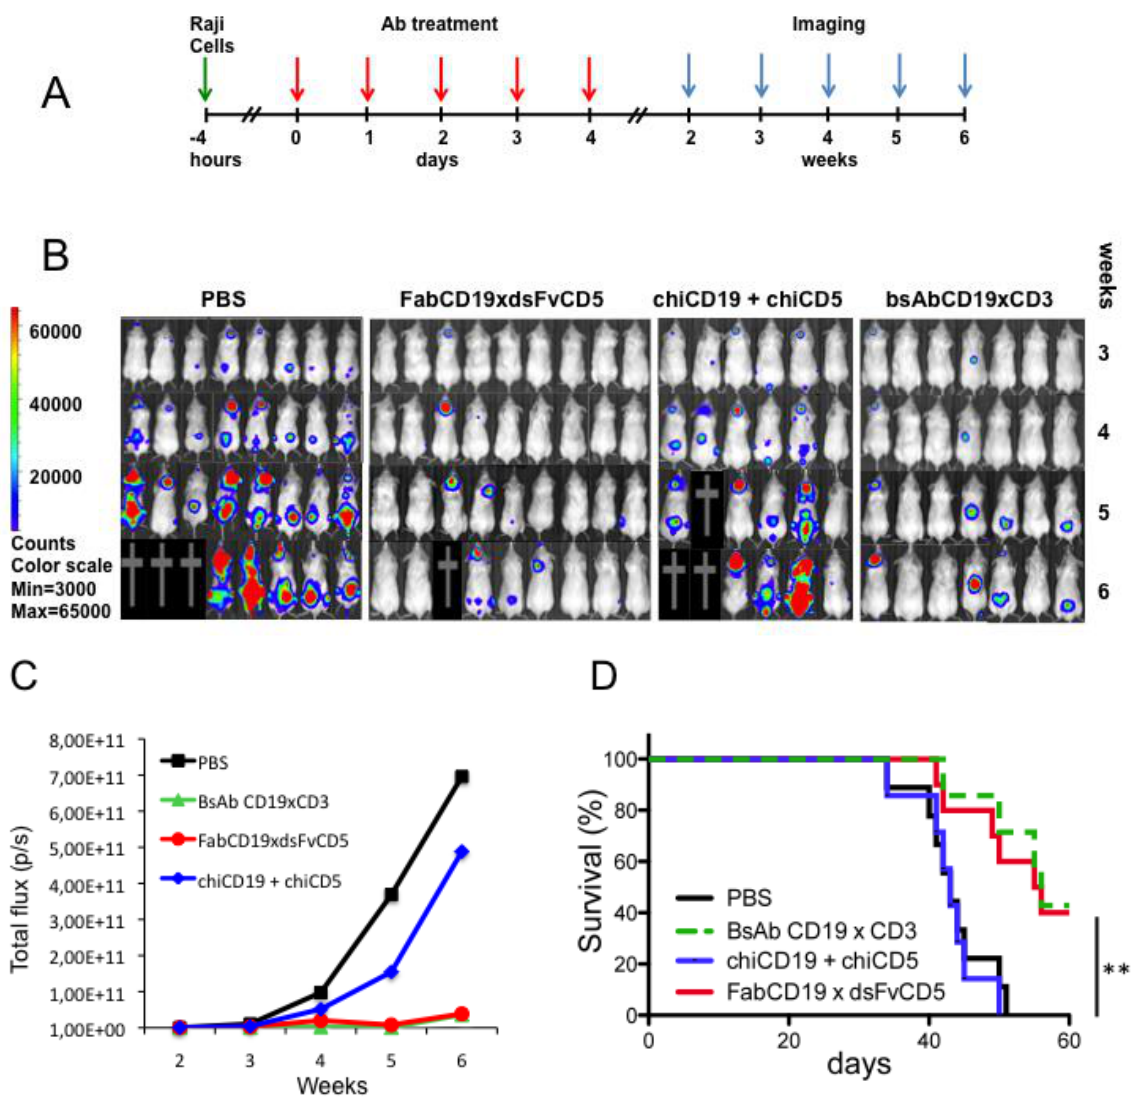
Figure 5. Influence of bsAb treatment on lymphoma growth in vivo . ( A ) Experimental design: NOD/SCID mice were intravenously inoculated with luciferase-transduced Raji lymphoma cells in combination with preactivated PBMC. Mice received five intraperitoneal antibody injections at the subsequent five days. Tumor growth was monitored by bioluminescent imaging for 6 weeks. ( B ) Luciferase imaging of 4 groups treated with PBS (negative control), bsAb FabBCE19xdsFvCD5 (investigative drug), mixture of mAb chiCD19 and chiCD5 (parental antibody control) and quadroma-derived bsAb CD19xCD3 (positive control). ( C ) Tumor growth during six weeks of observation measured by quantified bioluminescence (total flux). ( D ) Kaplan-Meier analysis of survival up to 60 days after tumor